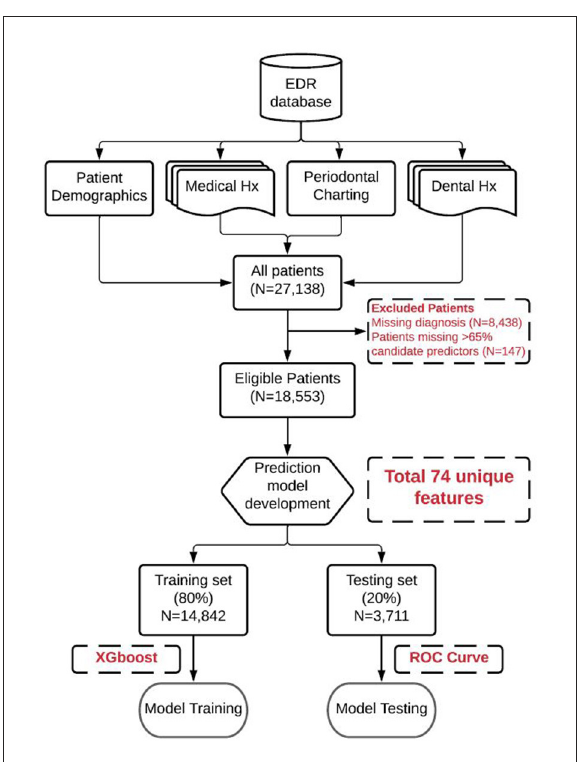
FIGURE3 Data extraction, cleaning, preprocessing, and machine learning model training and teasing (Overall workflow).